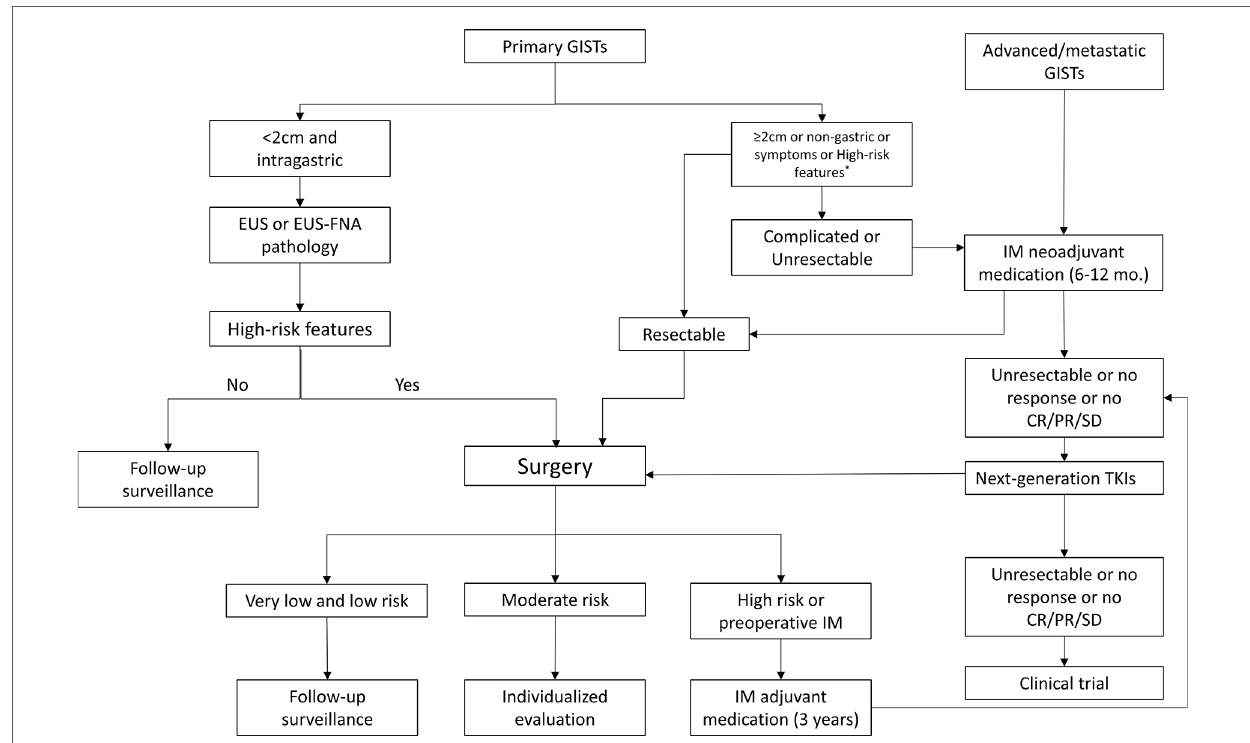
FIGURE 1 Management algorithm of primary and advanced/metastatic GISTs. GISTs, gastrointestinal stromal tumors; EUS, endoscopic ultrasonography; EUS-FNA, EUS-guided fi ne needle aspiration; IM, imatinib mesylate; TKIs, tyrosine kinase inhibitors; CR, Complete remission; PR, partial response; SD, stable disease; high-risk features refer to irregular and unclear border, echogenic foci, high mitotic rate, cystic degeneration, strong echo, ulcer, hemorrhage, and